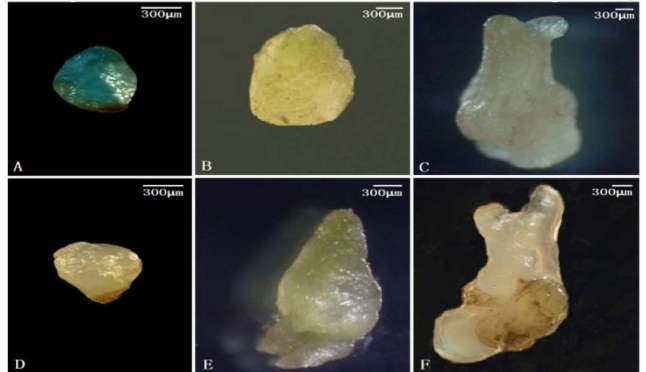
Figure 3. Transient expression analysis of promoter activity with pAS2 ( − 2090~ + 258) :: GUS and pAS5 ( − 772~ + 258):: GUS in three stages of immature